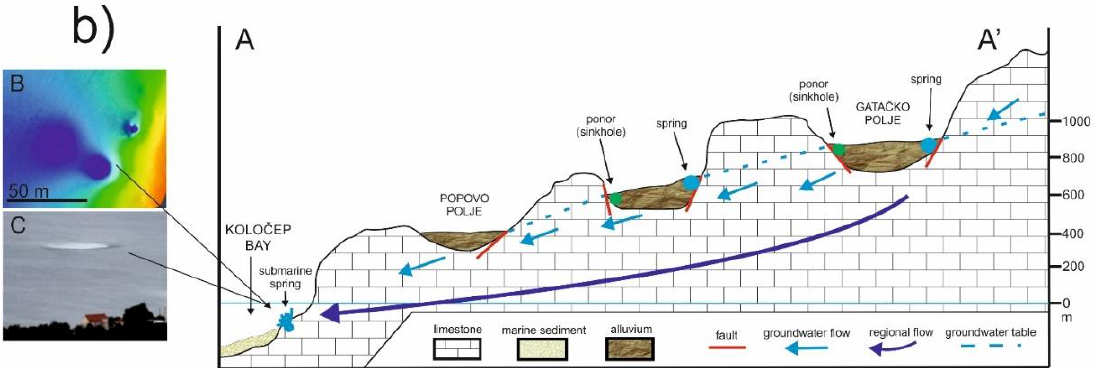
Figure 3. ( a ) Wide area of Doli–Slano littoral with larger karst poljes in the hinterland. Scattered appearances of ponors and springs and their underground connection (modified from [27,28,54]). ( b ) A–A’: schematic typical cross-section of cascade system through the karstic poljes of Dinarides (modified from [54]); B: recorded multibeam data; and C: recent submarine springs (vrulja) in the Doli–Slano area (photo taken by S. Miko).